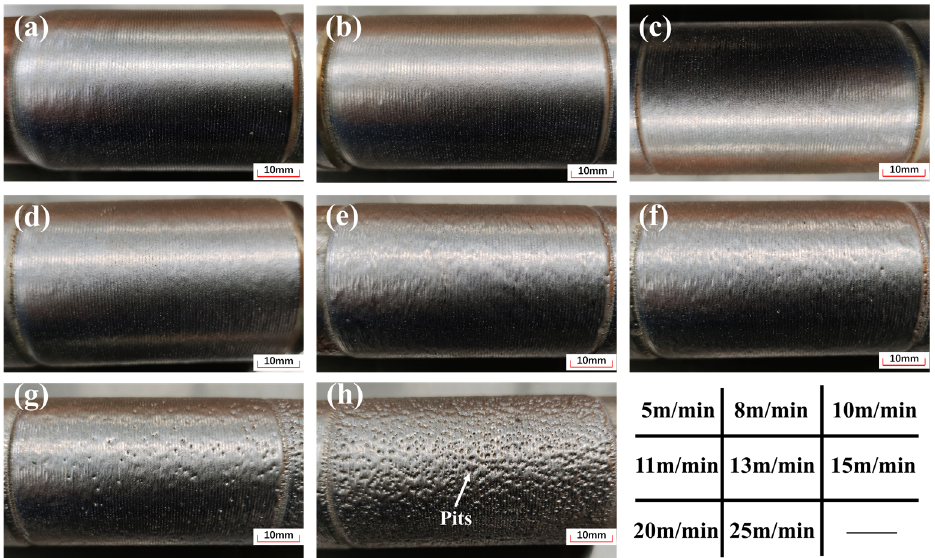
Figure 16. Macro-morphologies of EHLA coatings under different deposition speeds. ( a ) 5 m/min; ( b ) 8 m/min; ( c ) 10 m/min; ( d ) 11 m/min; ( e ) 13 m/min; ( f ) 15 m/min; ( g ) 20 m/min; ( h ) 25 m/min.